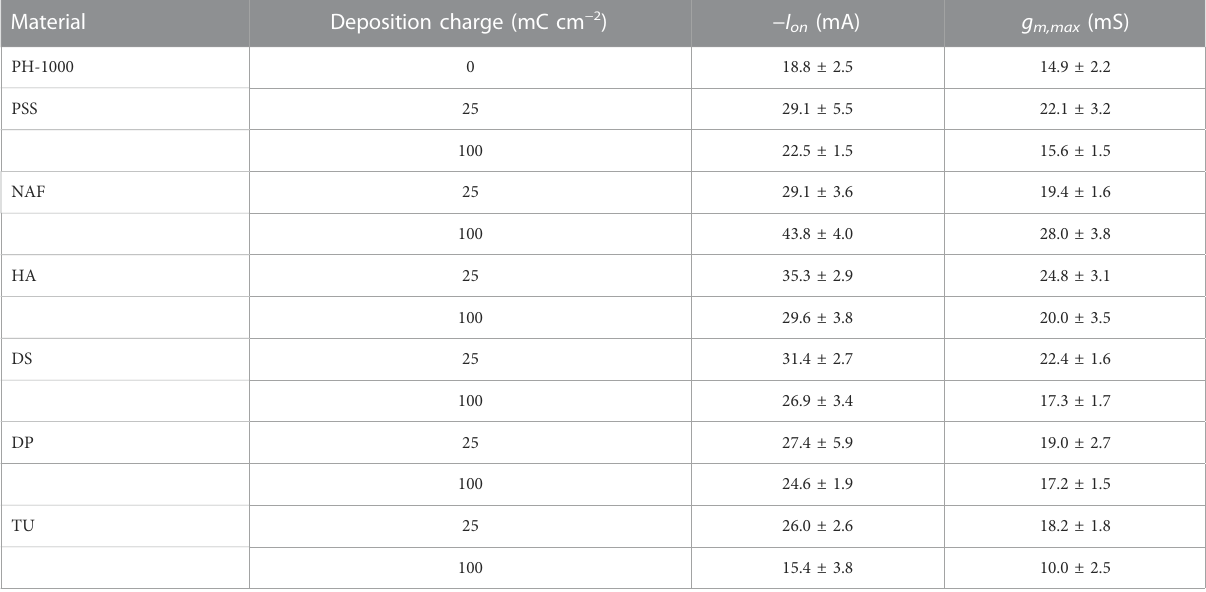
TABLE 1 Relevant data from OECT analysis based on PH-1000 and PEDOT/X deposited at Q dep = 25 mC cm − 2 or Q dep = 100 mC cm − 2 . Data are presented as mean ± SD from a set of three different devices.